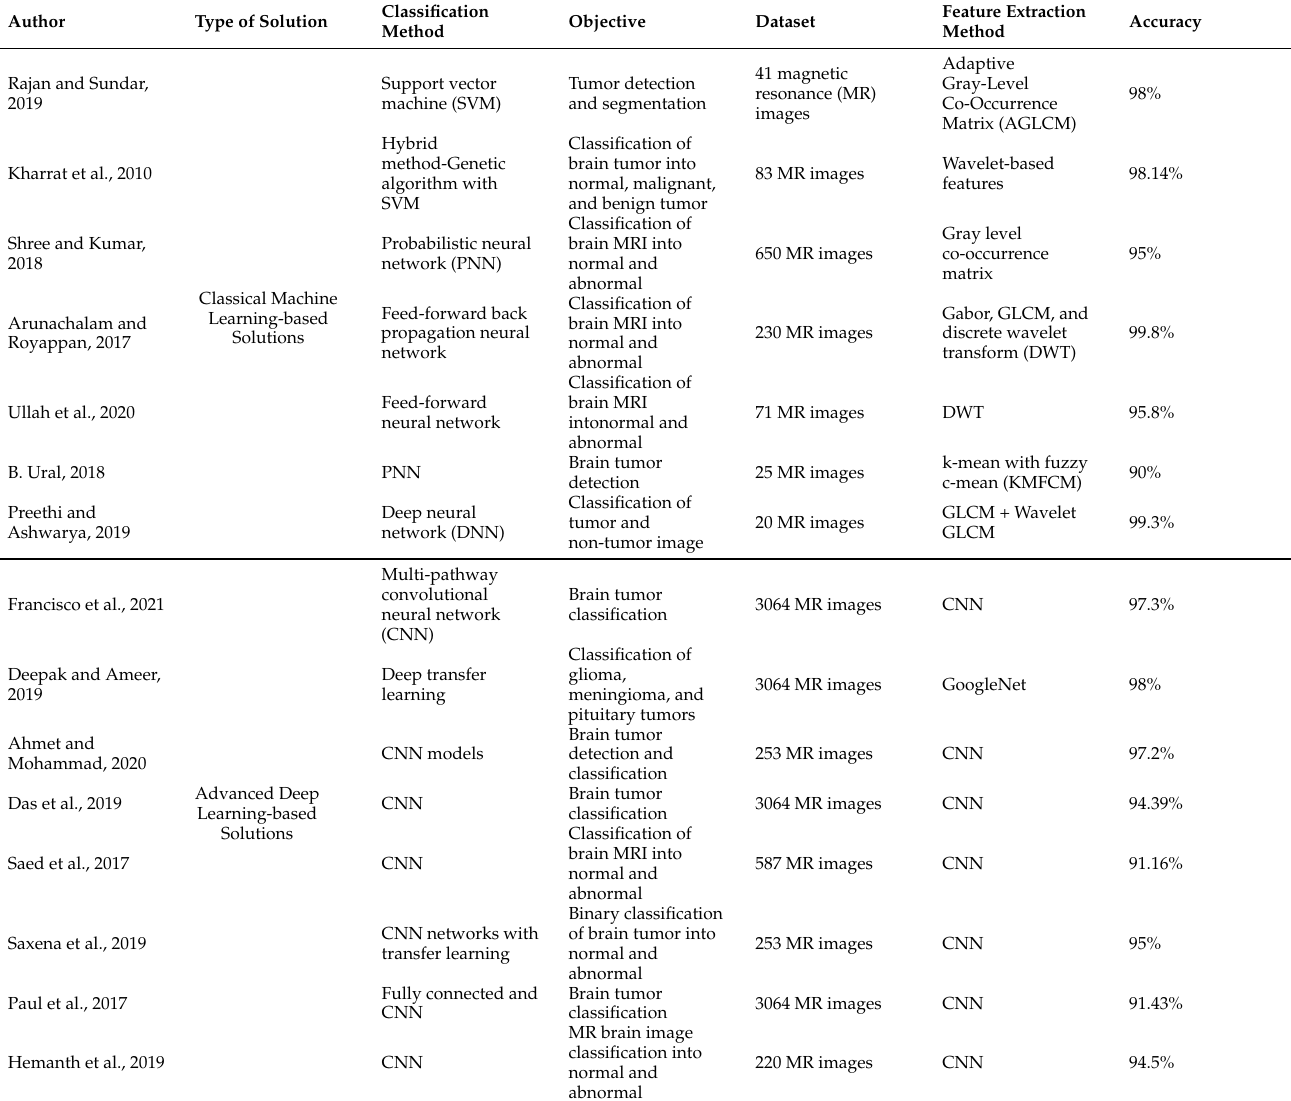
Table 1. Work Related to Brain Tumor